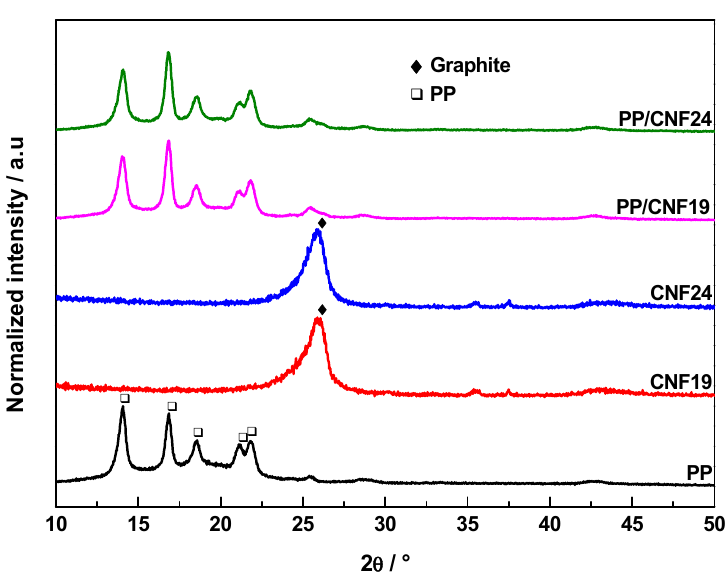
Figure 3. Representative XRD patterns of PP, as-received CNFs, and PP/CNF composites.